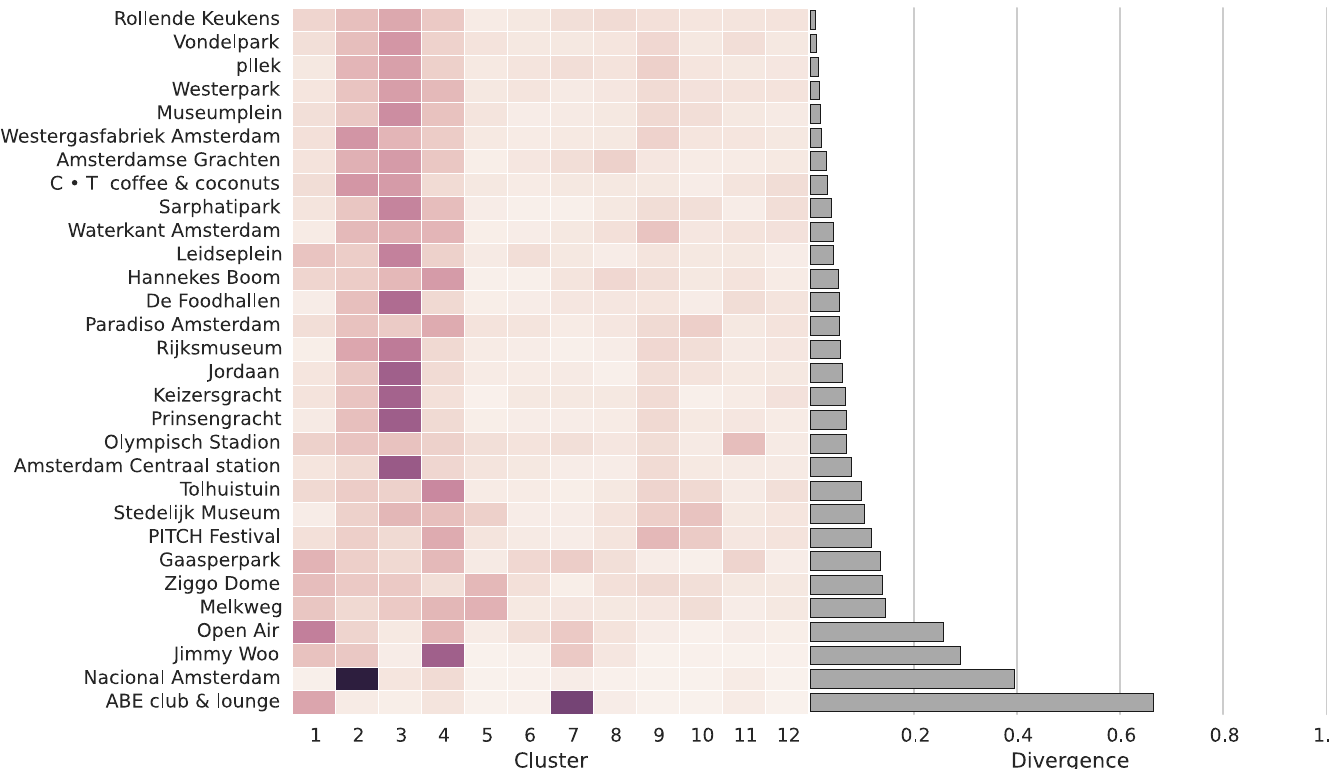
Fig 4. Visualization of place diversity in Amsterdam. The horizontal bar graph on the right shows the value of the divergence measure (DIV), with higher values indicating lower diversity. The heatmap in the middle indicates the relative presence or different clusters. Darker shaded cells shaded indicate greater presence of a cluster; white cells indicate complete